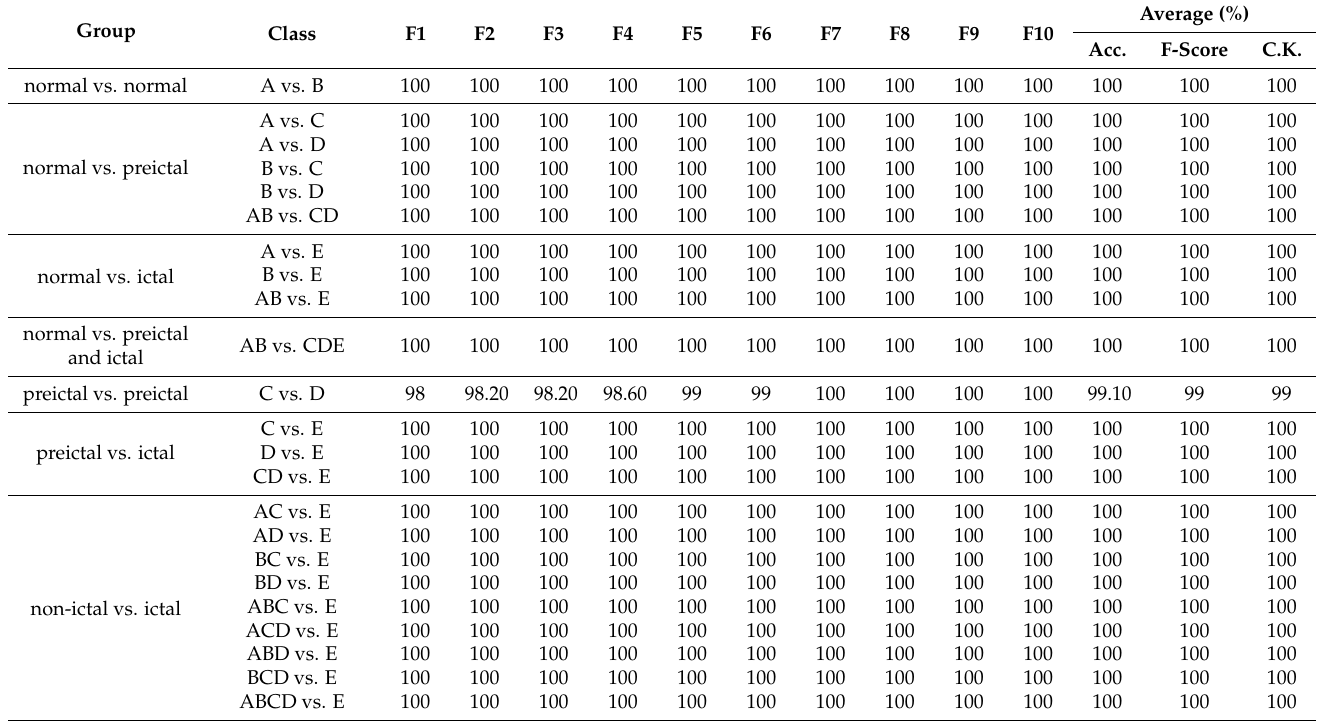
Table 2. Performance result of a binary class with 10-fold CV, here Fi means ith fold and all results are in (%).